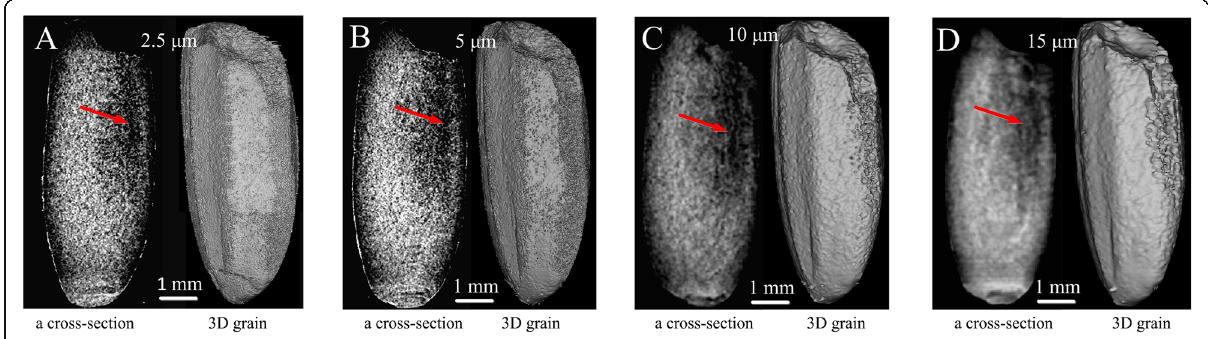
Fig. 2 3D reconstruction of rice (X220) under different X-ray scanning resolutions. A cross-section image and reconstructed 3D milled rice kernel with whit-belly chalkiness under X-ray scanning with resolution of 2.5 μ m ( a ), 5 μ m ( b ), 10 μ m ( c ) and 15 μ m ( d ). Dark areas indicated by red arrow represented the location of rice